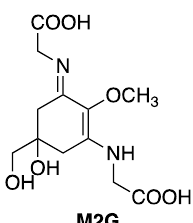
Figure 3. Analytical high performance liquid chromatography (HPLC) profiles of ( a ) M2G, ( b ) SHI, and ( c ) P334. The retention times of M2G, SHI, and P334 were 5.9, 5.6, and 8.4 min, respectively. The molecular structures of these purified MAAs were confirmed by NMR analysis. The NMR data is shown below.